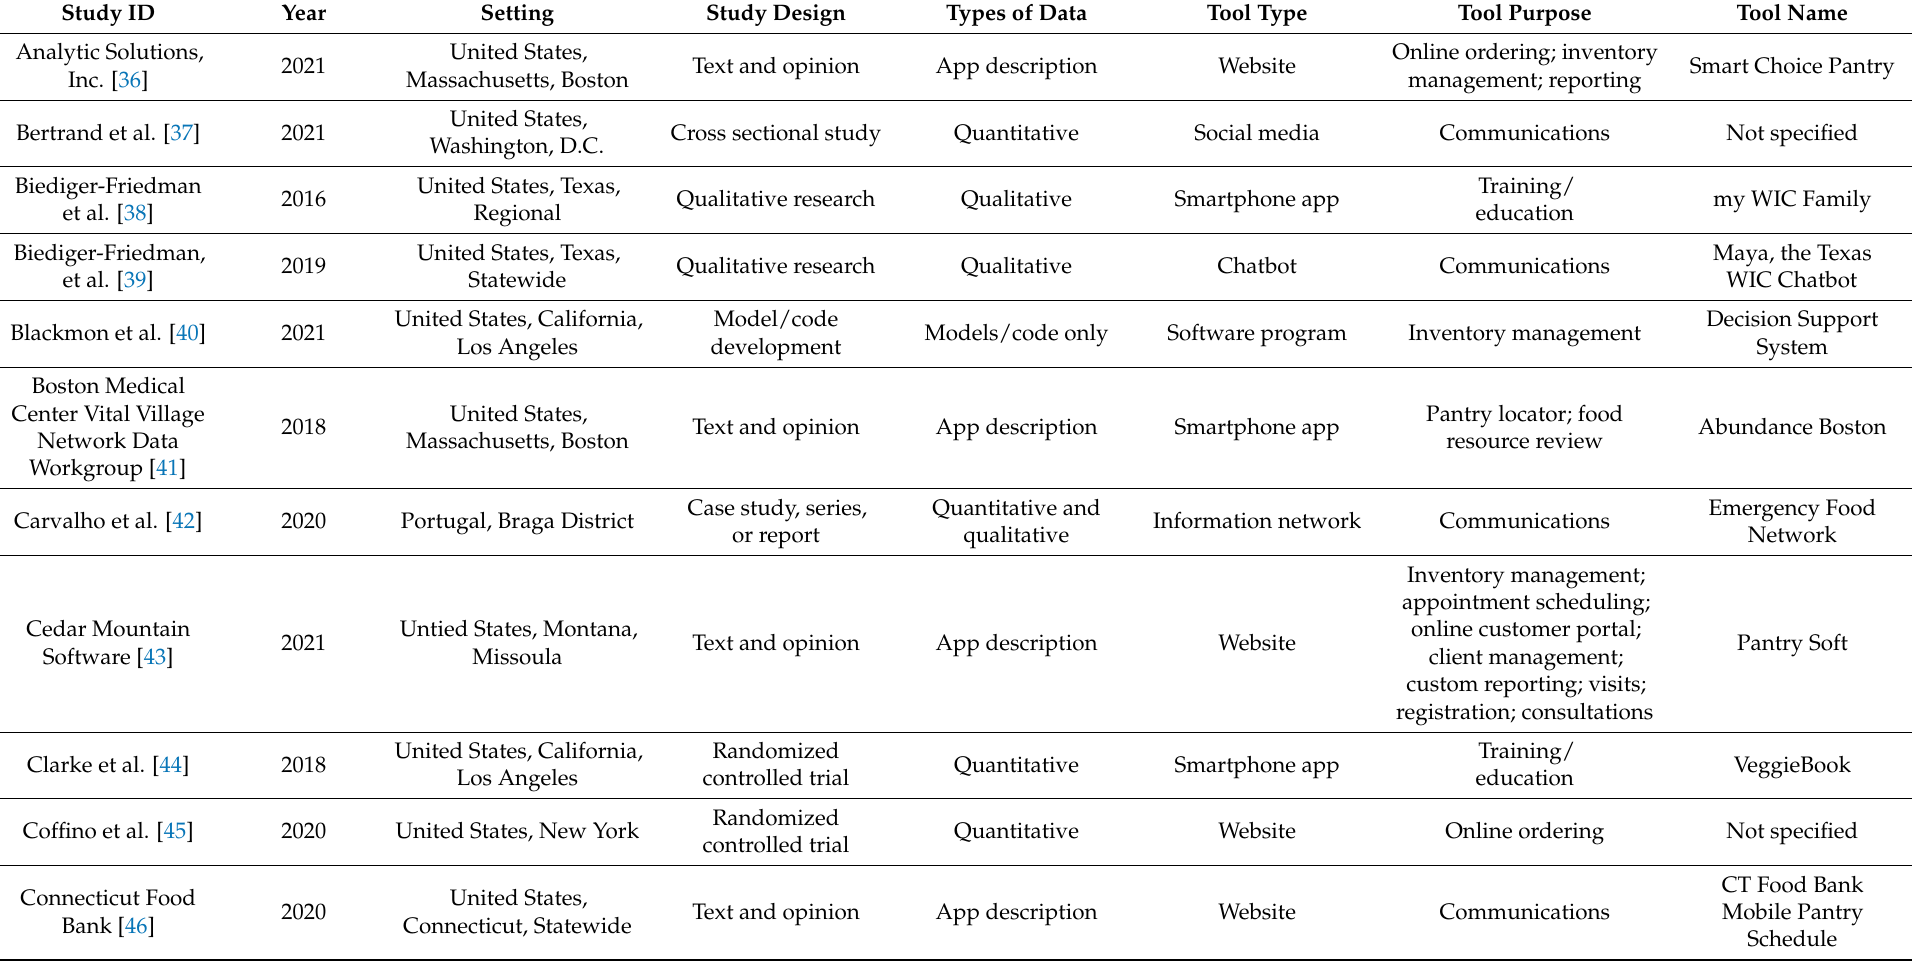
Table 3. Characteristics of reviewed articles ( n =